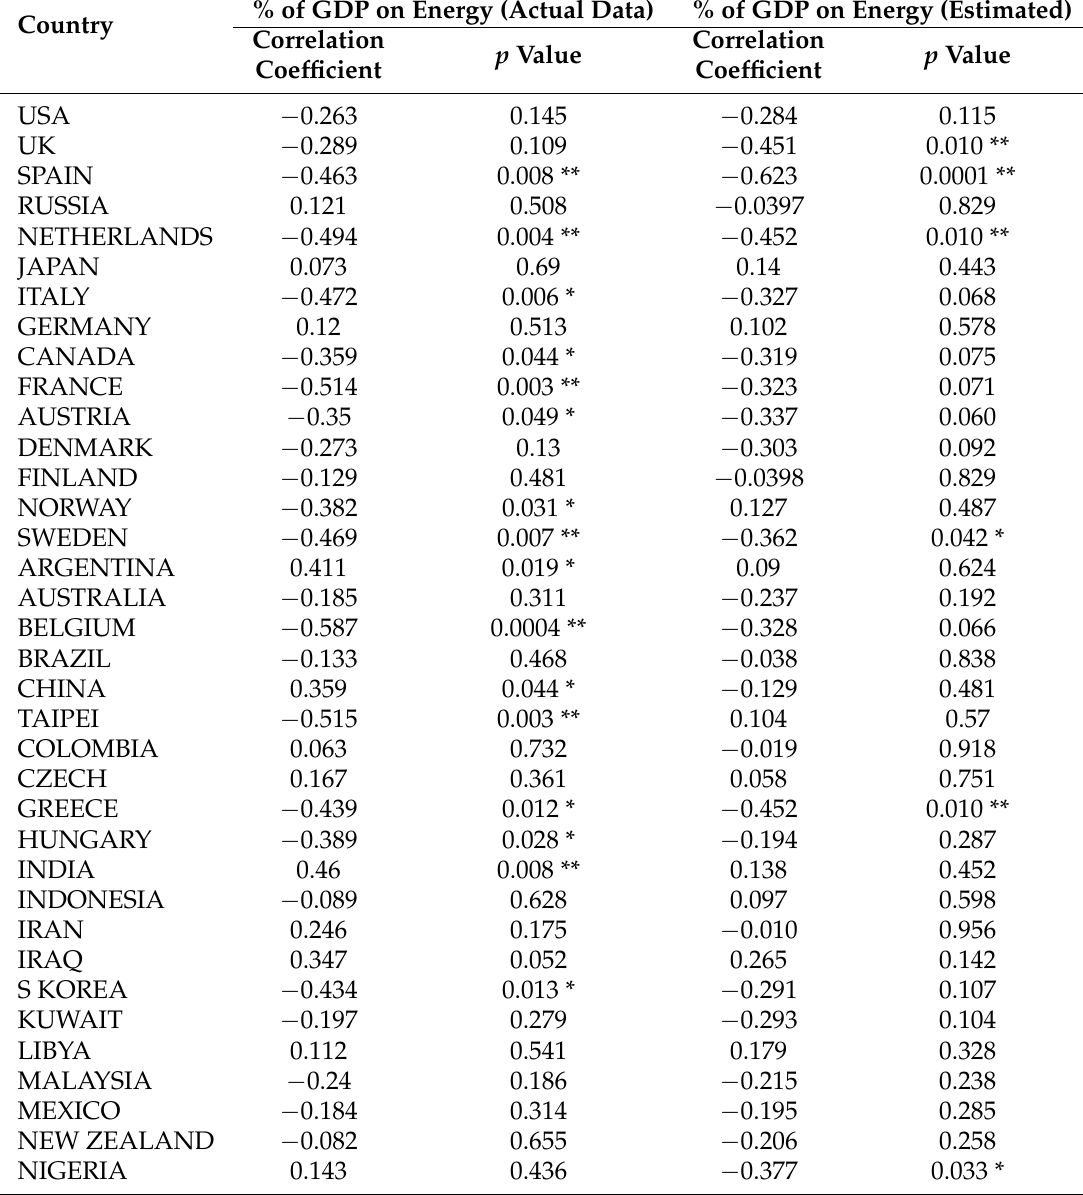
Table 1. The negative correlation of the ratio of GDP for all energy expenditures to the 1 year lag in annual change in GDP is statistically significant for several countries with the most severe economic stress, and statistically significant for the world overall. * = p value < 0.05; ** = p value < 0.01. The countries in this table account for approximately 93% − 95% of world